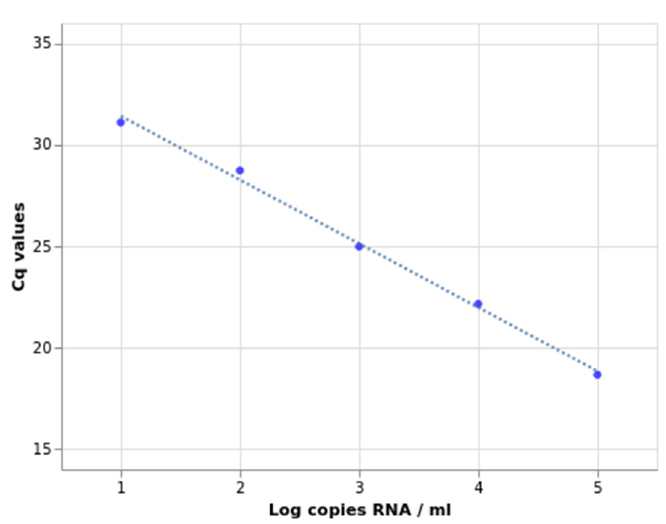
Figure A1. The effectiveness of the SARS-CoV-2 RT-qPCR is 108%. The slope of the standard curve is − 3.14.